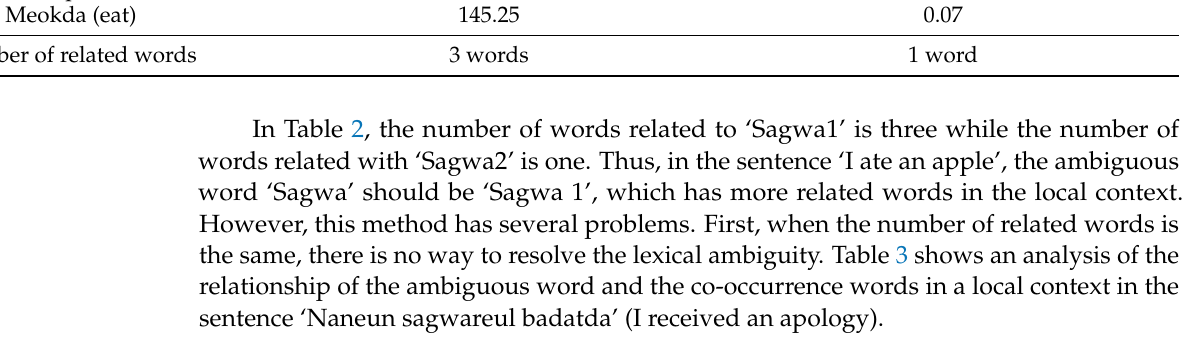
Table 3. Example of failure of relationship analysis between words using the chi-square test of independence. Co-Occurrence